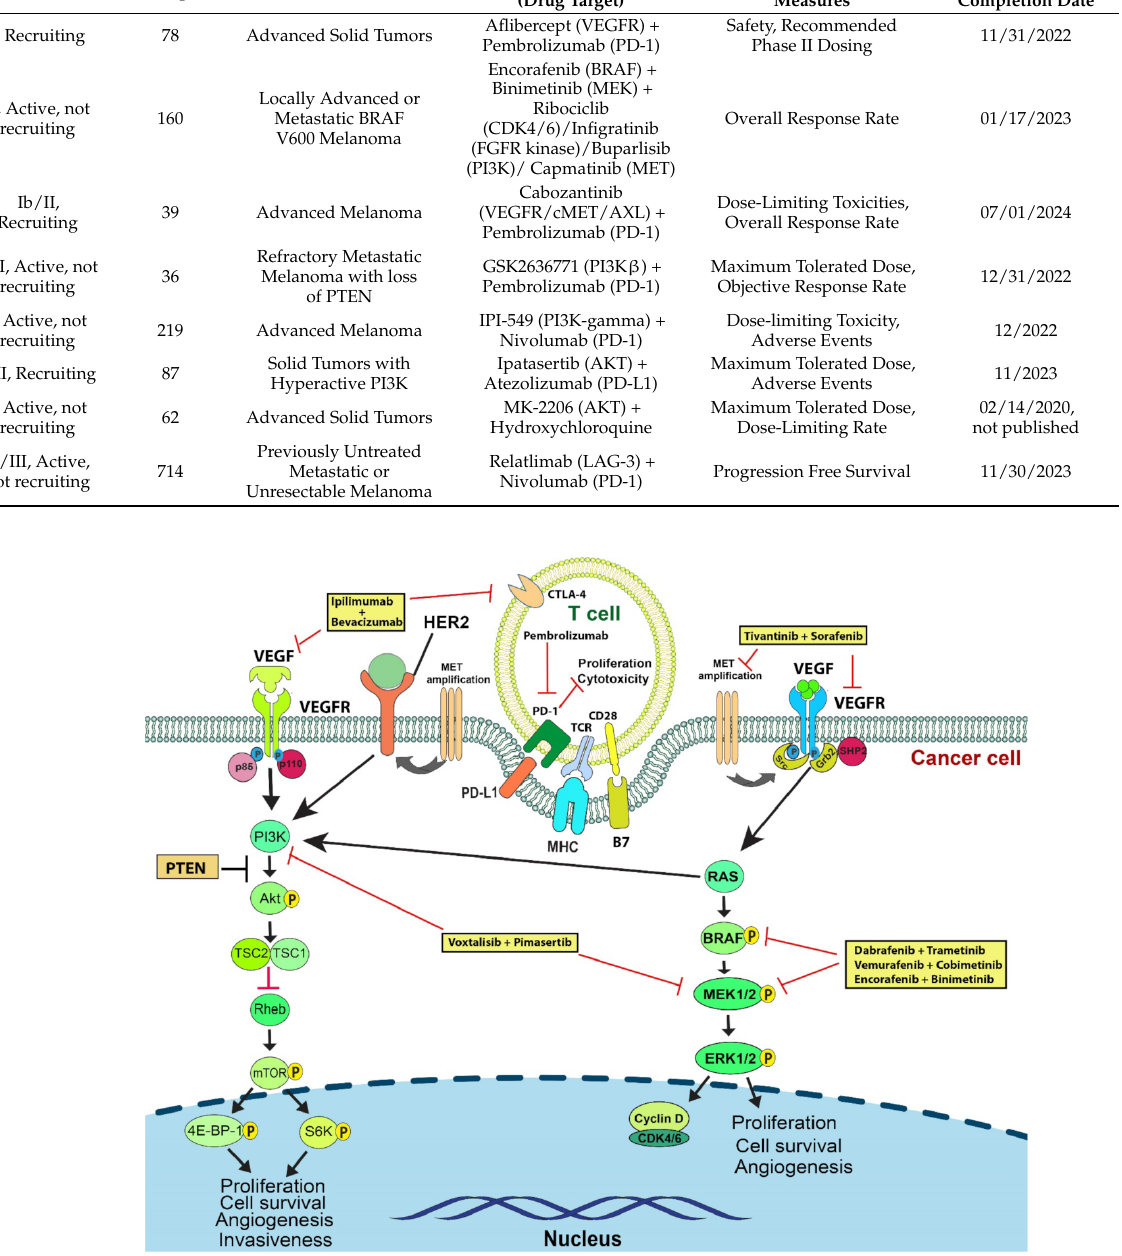
Figure 1. Combination therapies targeting T cell and the RAS/RAF/MAPK and PI3K/AKT pathways which regulate cell proliferation in melanoma. Growth factors, such as VEGF, bind to their receptors and activate receptor tyrosine kinase (RTK), which phosphorylates Grb2, which then forms a complex with SOS. SOS induces a conformational change in Ras to favor Ras binding to GTP. GTP-bound Ras activates the Ras/MEK/ERK and PI3K/AKT/mTOR pathways, promoting tumorigenesis, angiogen- esis, and cell motility. One of the downstream effects of Ras activation is the expression of cyclin D, which activates CDK4/6 and allows for progression of the cell cycle. Furthermore, melanoma cells employ multiple ways to evade immunosurveillance, for example, through the PD-L1expression. The induction of PD-L1 with the PD-1 receptor on T cells suppresses T cell proliferation and effector functions. Combination therapies (yellow boxes) targeting different parts of these pathways may exert synergistic anti-tumor effects or prevent the development of resistance to